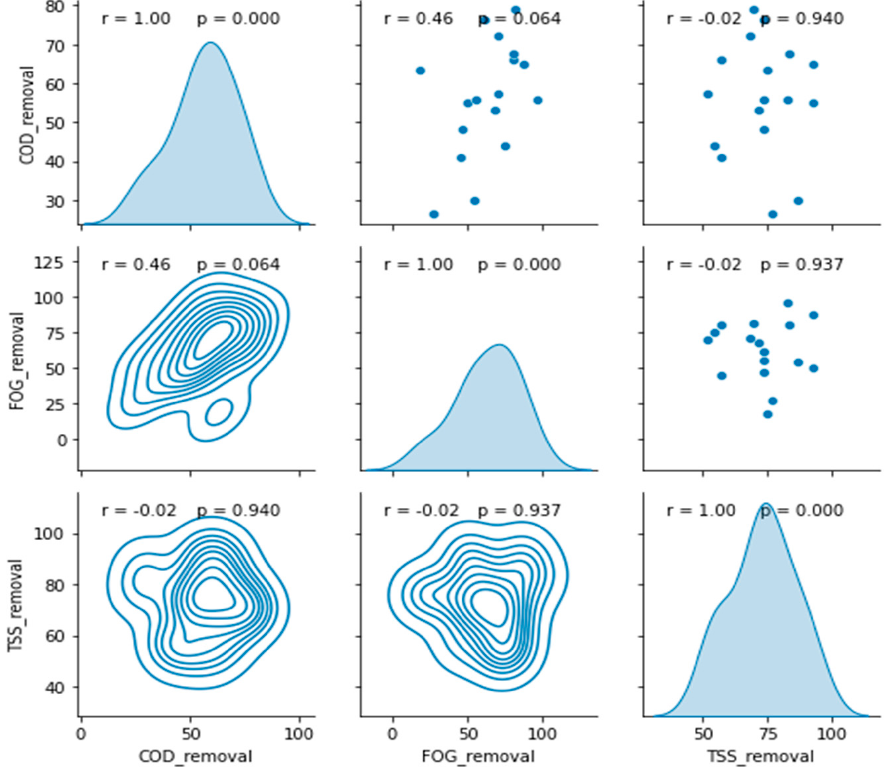
Figure 12. Correlation matrix between the EGSB removal